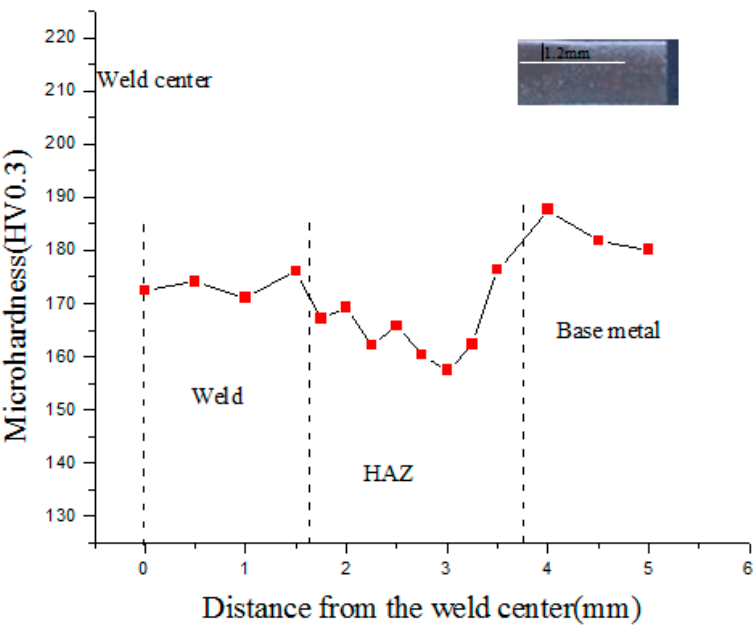
Figure 13. Microhardness profile on the weld cross ‐ sections of the joint.